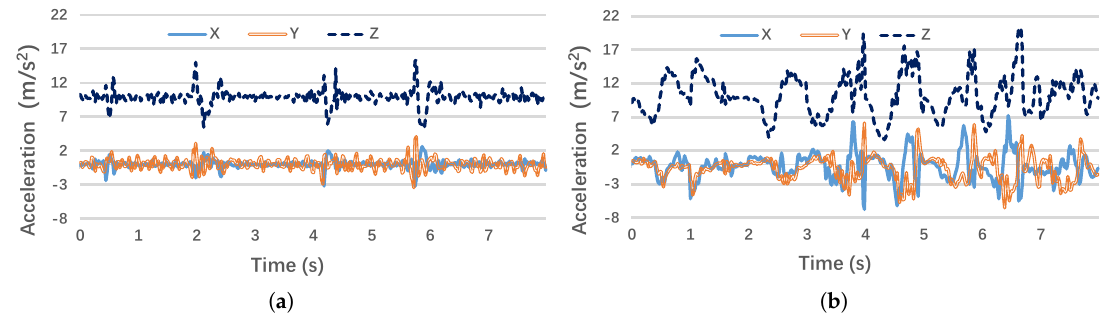
Figure 5. Accelerometer data from different actions: ( a ) Writing actions; ( b ) Hand-up-down